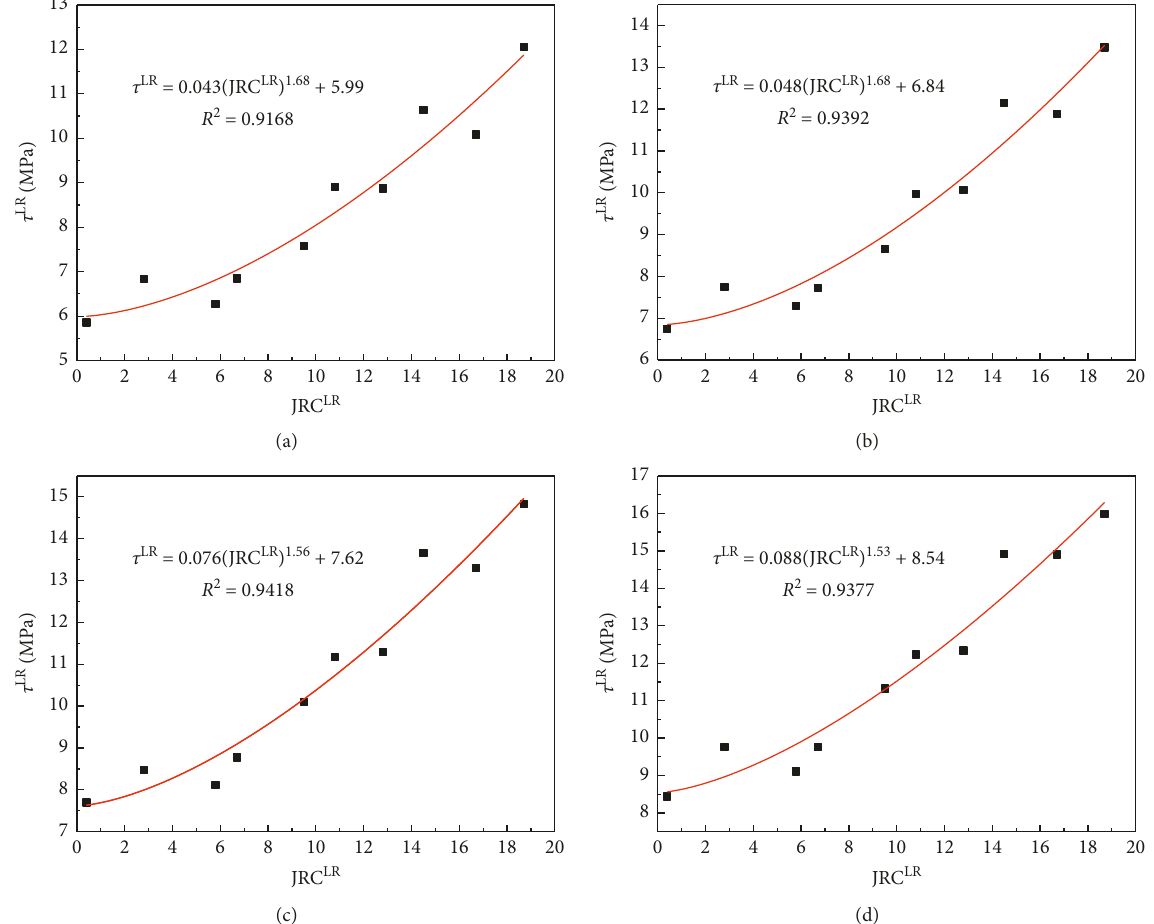
Figure 13: The fitting relationships between JRC LR and τ LR . (a) σ